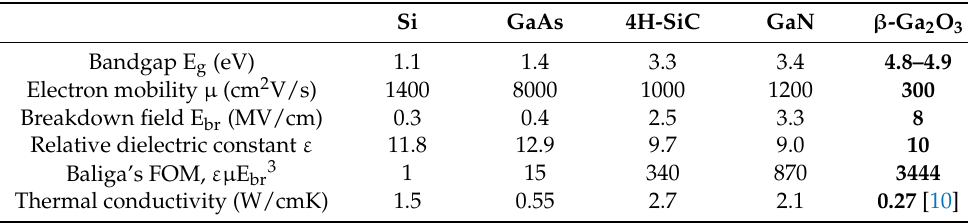
Figure 1. The pentagon diagram shows the essential material characteristics of semiconductor power devices. Reprinted with permission from Ref. [17], 2018, AIP Publishing.. devices. Reprinted with permission from Ref. [17], 2018, AIP Publishing.. Table 1. Material properties of various WBG semiconductors and β -Ga 2 O